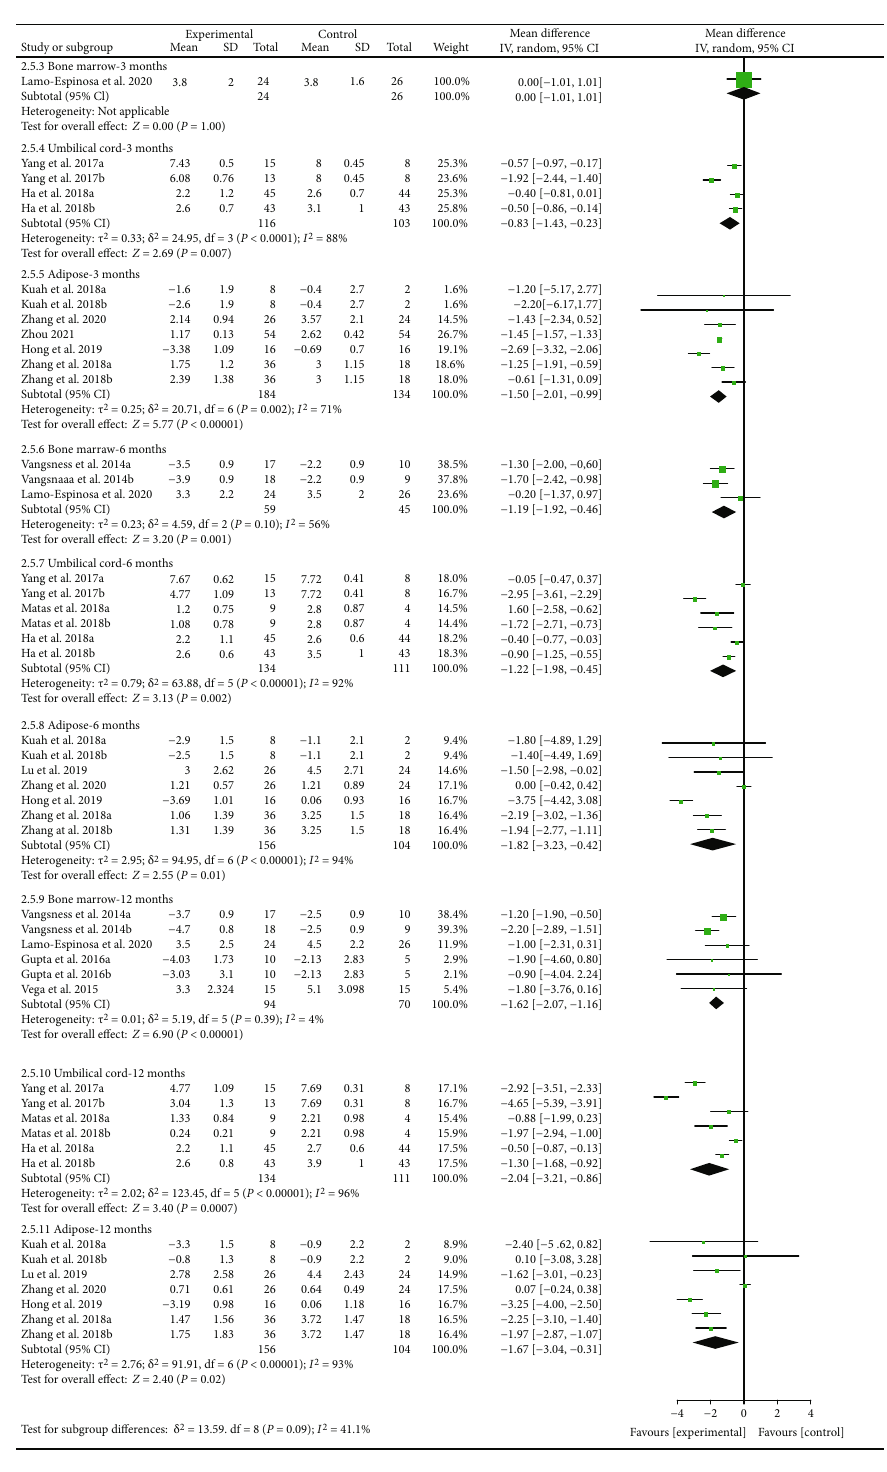
Figure 10: VAS-di ff erent cell